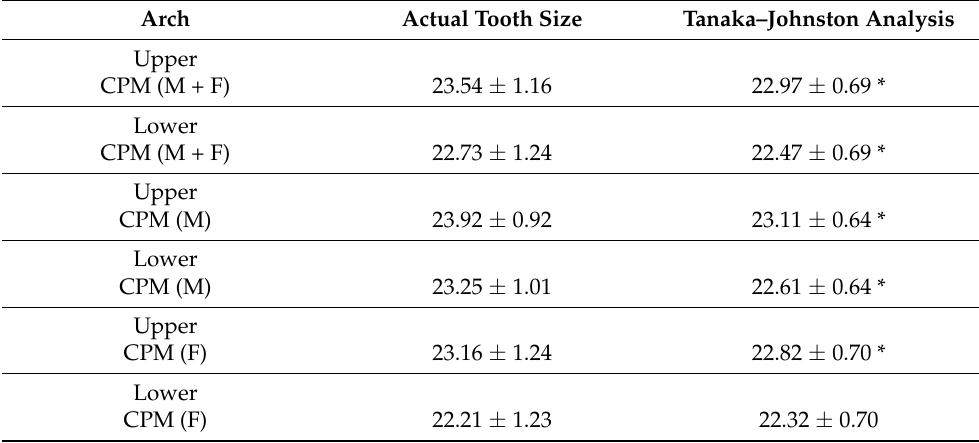
Table 3. Actual tooth size and tooth size predicted by the Tanaka–Johnston analysis.